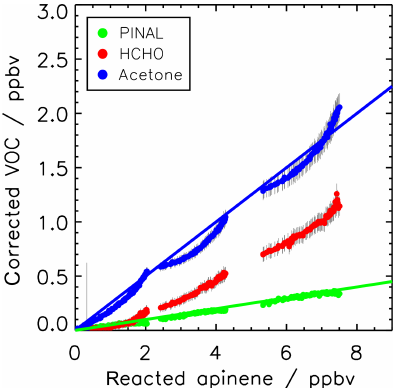
Figure 2. Yield of pinonaldehyde, acetone, and formaldehyde de- termined from the slope of the relation between consumed α -pinene and measured oxidation product concentrations for the experiment on 2 July 2014. Organic oxidation product concentrations are cor- rected for losses and production not related to the α -pinene + OH reaction (see text for details). Colored lines give the results of a linear regression. The HCHO yield is determined from the initial slope but increases at later times of the experiments as indicated by the increasing slope of the